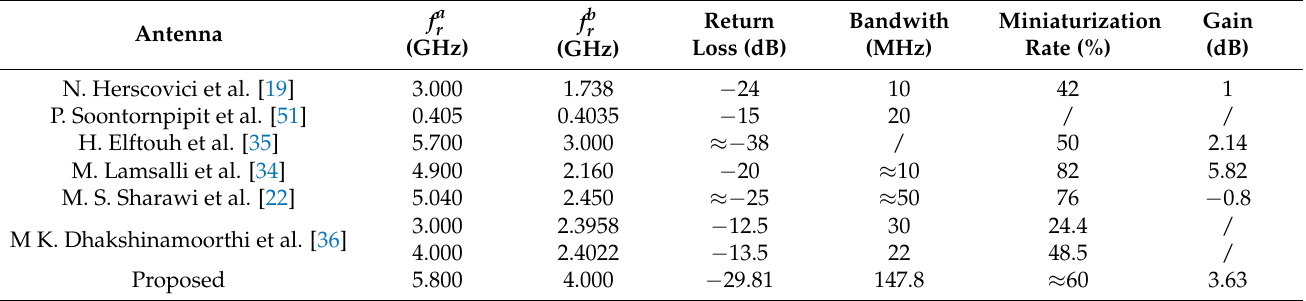
Table 3. Comparison of the proposed antenna with reference miniaturized patch